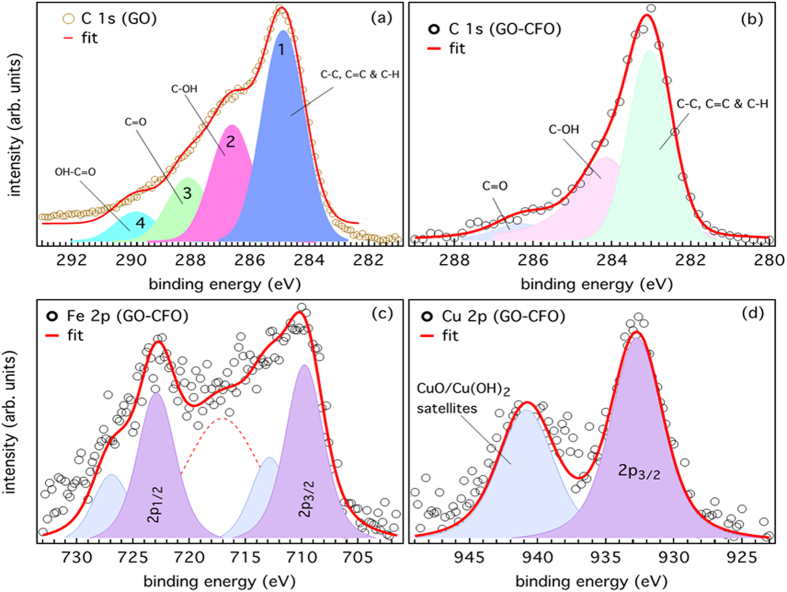
C 1s core-level spectra of (a) GO, (b) GO-CuFe2O4 nanocomposite samples. (c) Fe 2p and (d) Cu 2p core-levels of GO-CuFe2O4 sample.